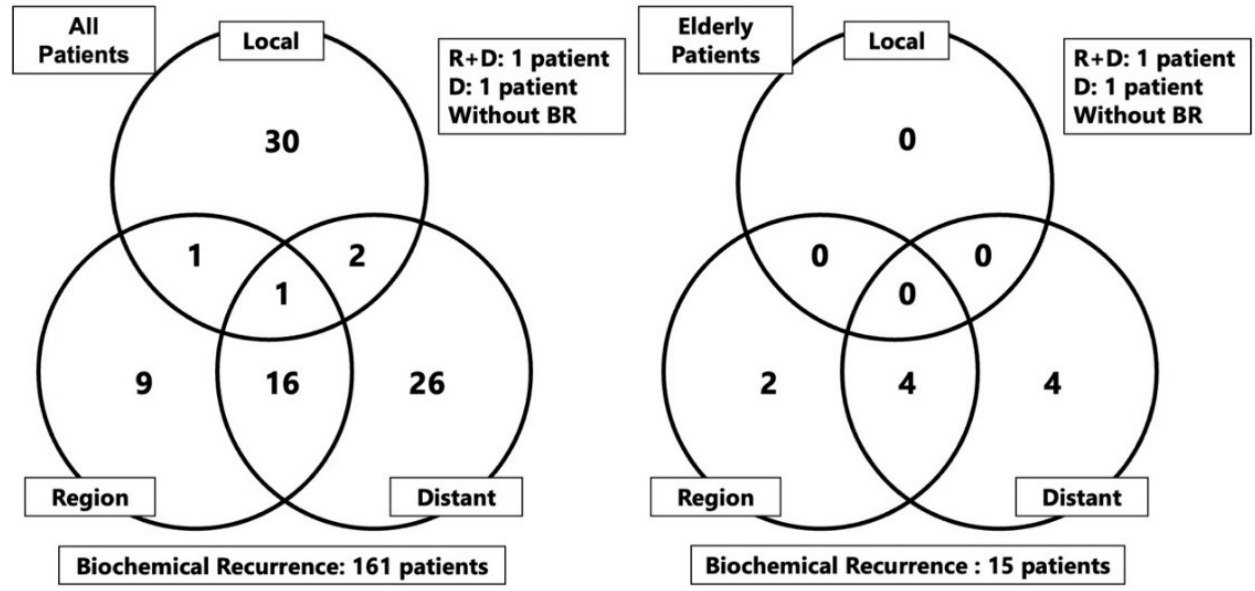
Figure 1. Form of recurrences after carbon-ion radiotherapy in the overall study population and elderly group. Abbreviation: R: region, D; distant, BR: biochemical recurrence.